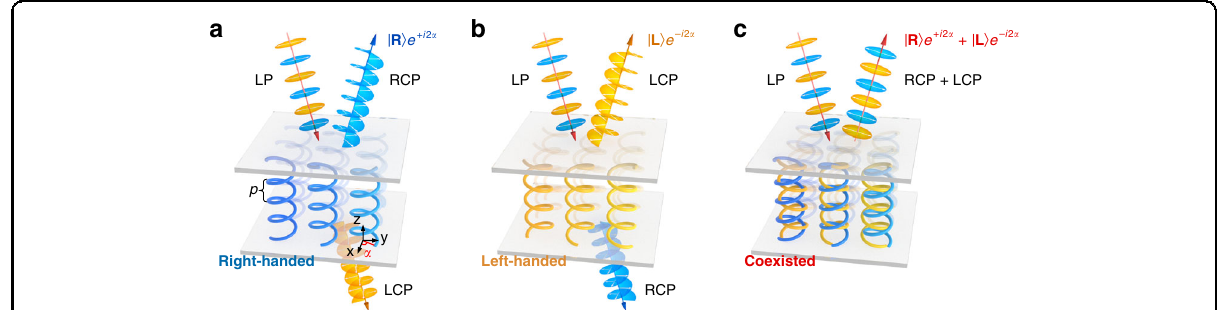
Fig. 1 Schematic illustration of common CLC superstructures and opposite-chirality-coexisted superstructures. a With the incident light of linear polarization (LP), for right-handed CLC, the right circular polarization (RCP) component is re fl ected and added by a re fl ective PB phase of + 2 α (i.e., R j i e þ i 2 α ), while left circular polarization (LCP) component is transmitted . α represents the orientation angle of the surface LC director. p stands for the helical pitch of the CLC. b For left-handed CLC, the LCP component is re fl ected and added by a re fl ective PB phase of - 2 α (i.e., L j i e (cid:2) i 2 α ), while the RCP component is transmitted. c For opposite-chirality-coexisted superstructures, both the RCP and the LCP components are re fl ected and added by the conjugated PB phase (i.e., R j i e þ i 2 α þ L j i e (cid:2) i 2 α